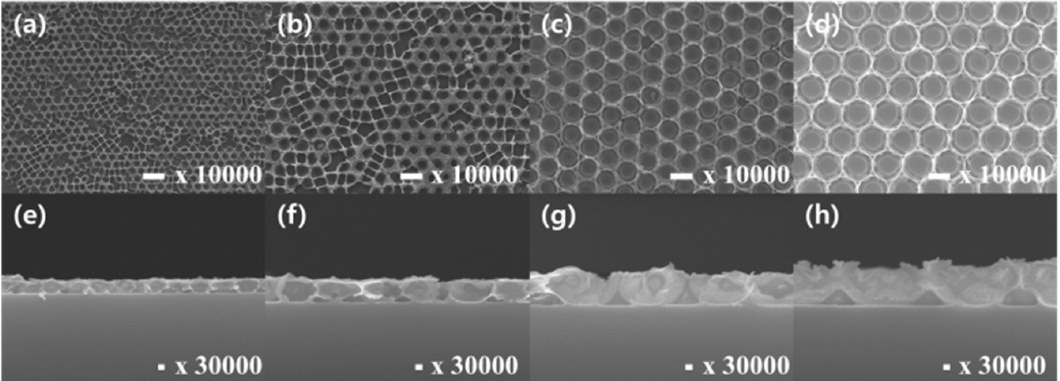
Figure 1. FE-SEM images of the top and cross-sectional views of the fabricated structures from the polystyrene(PS) patterned TiO 2 films with 400 nm ( a ), ( e ), 700 nm ( b ), ( f ), 1000 nm ( c ), ( g ) and 1300 nm ( d ), ( h ). Scale bars were 1000 nm for ( a ), ( b ), ( c ), ( d ), and 3000 nm for ( e ), ( f ), ( g ), ( h ).